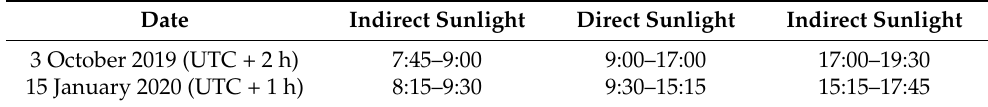
Table 2. Sunlight exposure periods during the tests.